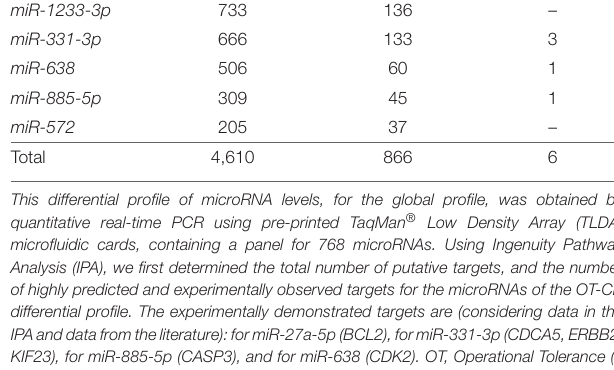
predicted and experimentally observed